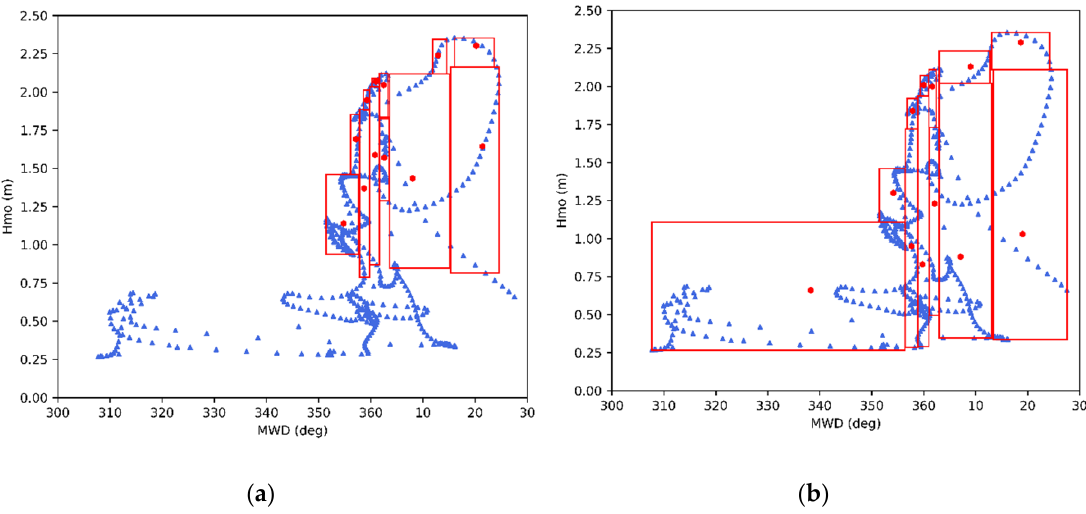
Figure 5. Scatter plot showing the full dataset of the 20 days (blue markers) along with the bins (red rectangles) and representative wave conditions (red markers) using the pick-up rate method ( a ) and the energy-flux method ( b ).